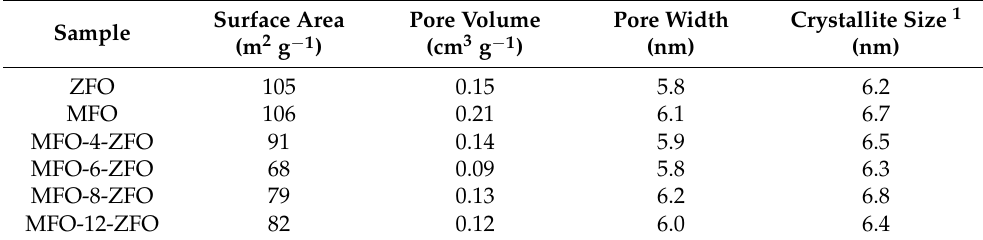
Table 1. Textural properties of mesoporous assemblies of ZFO and MFO